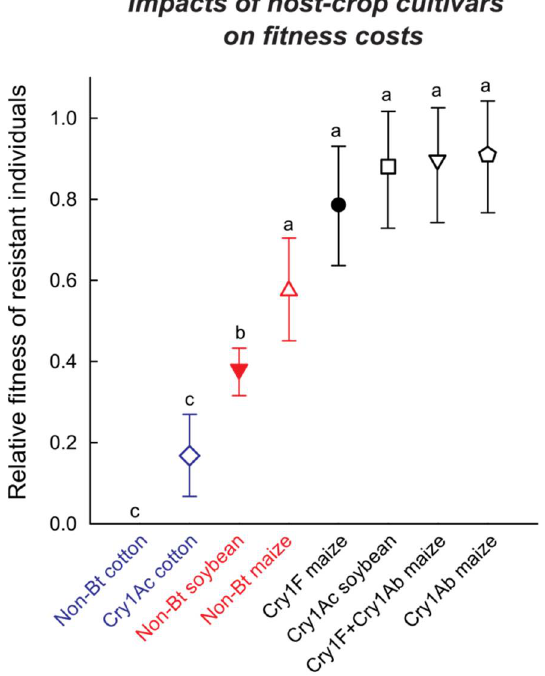
Figure 5. Effect of host-crop cultivars on the fitness costs of resistance to dual-gene Bt maize (Cry1A.105+Cry2Ab2) in the invasive fall armyworm ( Spodoptera frugiperda ). The relative fitness index was calculated by dividing the fitness index value of the Bt-resistant population by the fitness index value of the susceptible population. Means ± standard errors followed by the same letter are not significantly different (Scott-Knott test, p > 0.05).